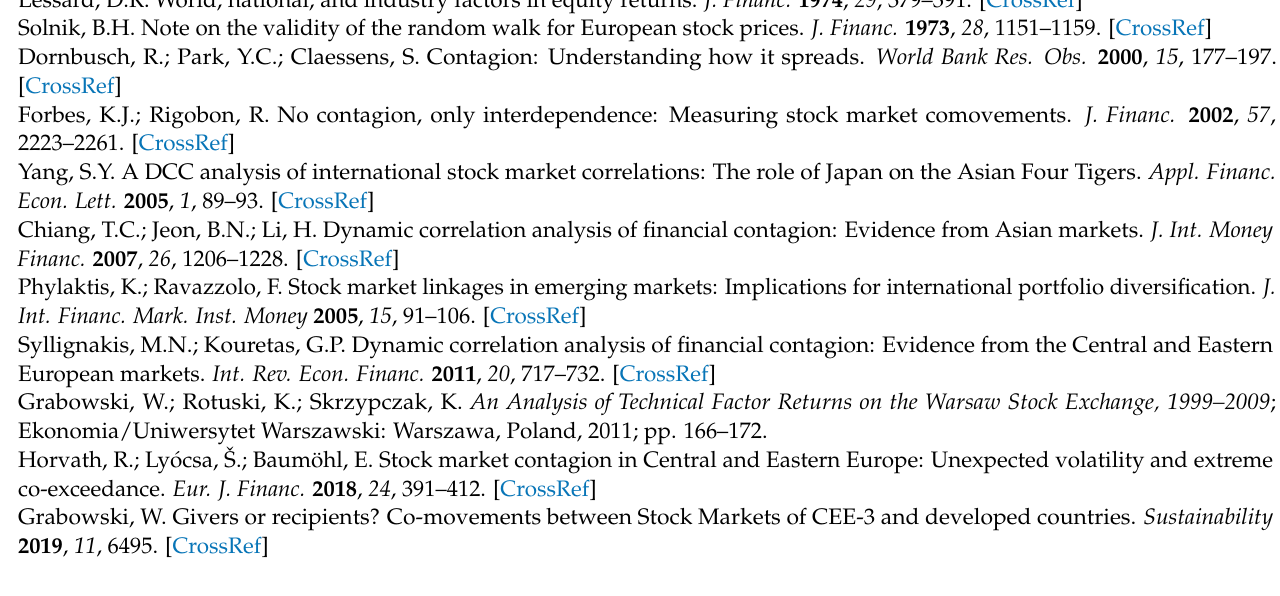
Figure A11. Variance Decomposition Analysis in Both Regimes.